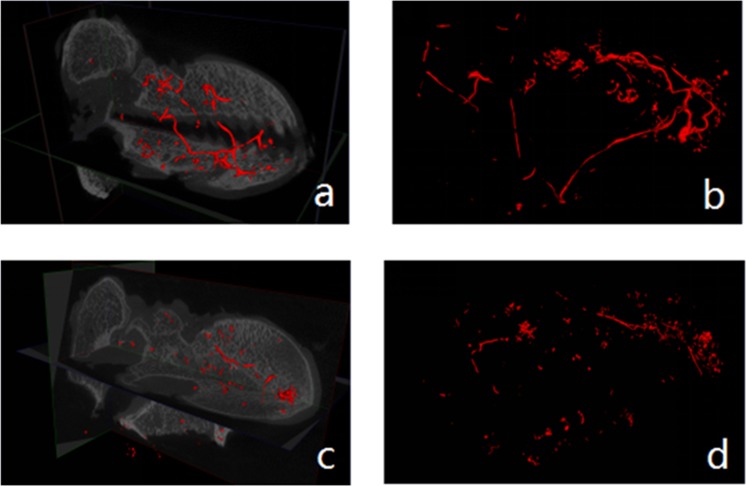
3D images of microvessels and bone structure.The three-dimensional images of microvessels and bone structure (left) in the femoral heads could be displayed simultaneously through Isosurface of Micro View software. By choosing the appropriate CT values, the information of microvessels (right) could be extracted separately. The images demonstrated that the microvessels in the experimental group (a,b) were more evenly and broadly distributed than in the control group (c,d).